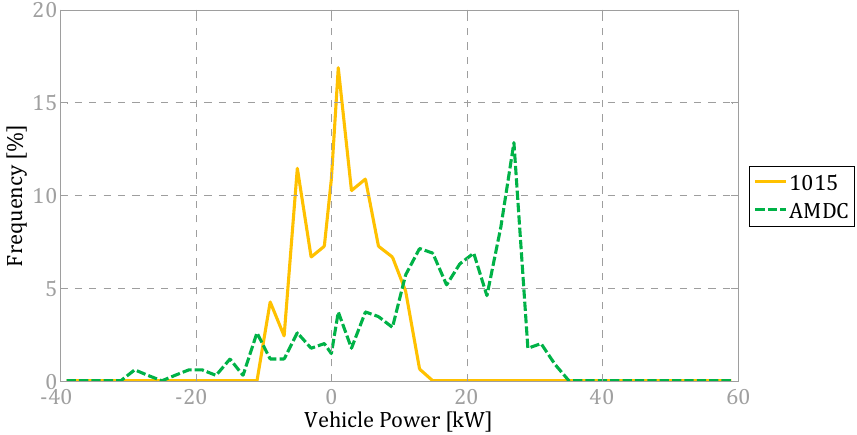
Figure 3 Vehicle power frequency distribution for the two driving missions. Figure 3. Vehicle power frequency distribution for the two driving missions.